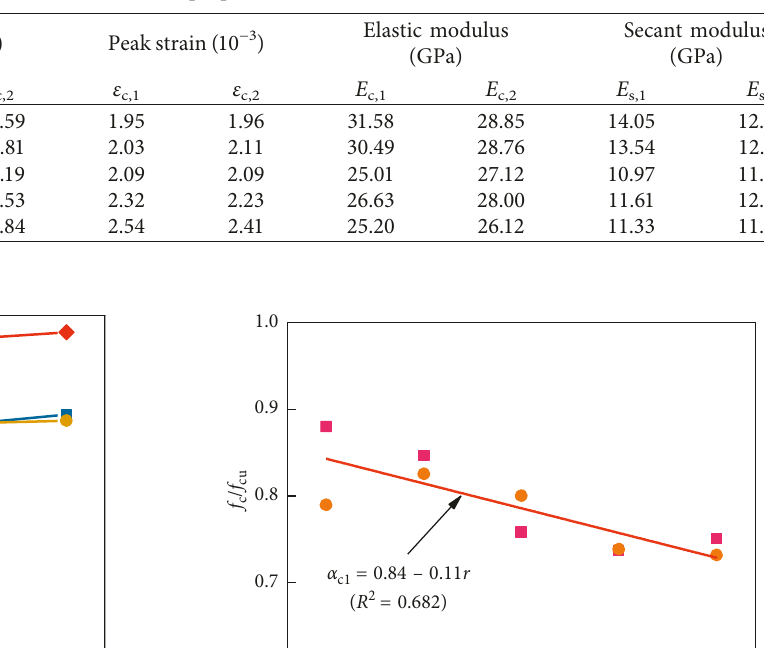
Table 3: Main mechanical properties of the